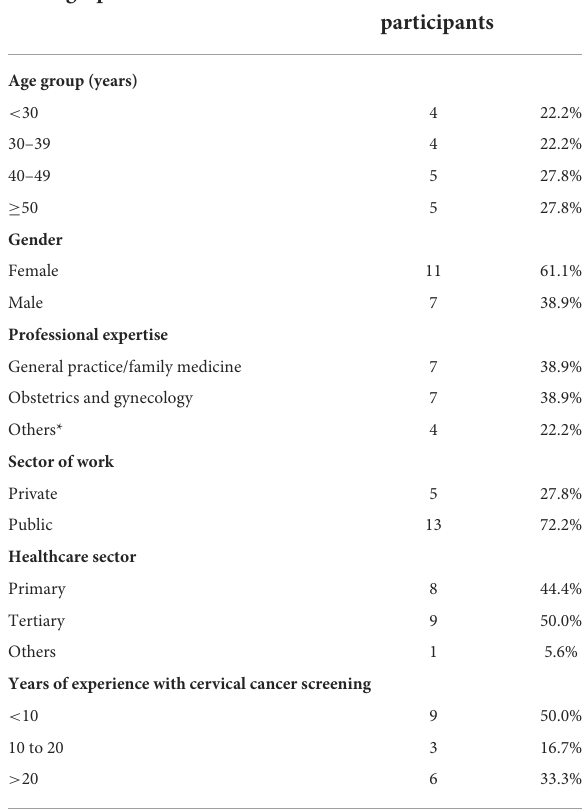
TABLE 1 Demographics of study participants ( n =